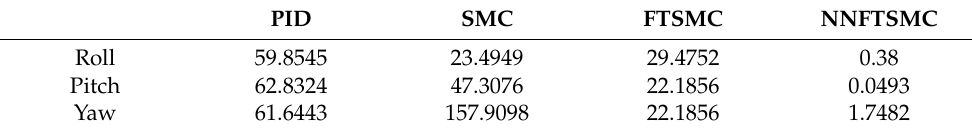
sine trajectory.